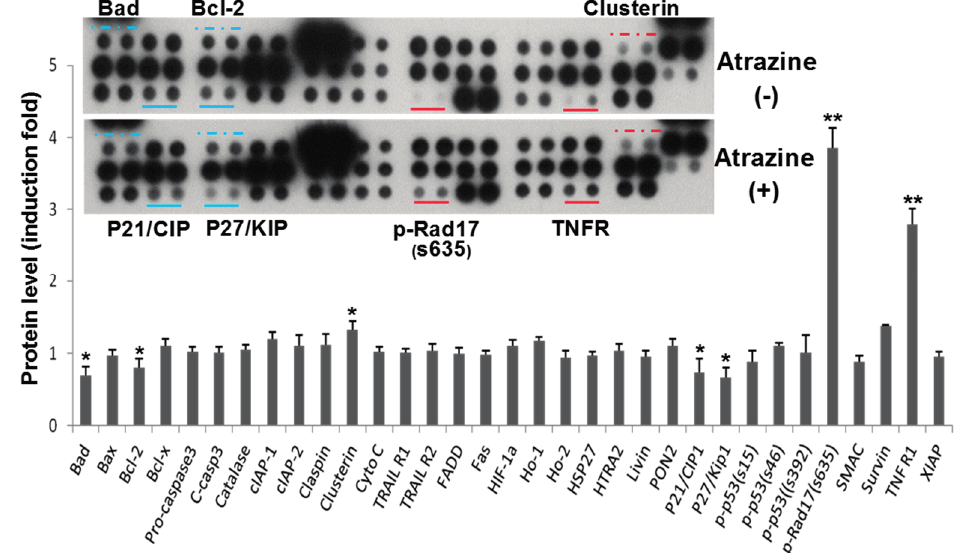
Figure 2. Atrazine regulates proteins related to apoptosis in MCF-10A cells. Cells (1 × 10 6 ) were exposed to 0.1 μ g/mL of atrazine for 6 h. Cell lysates were used for antibody